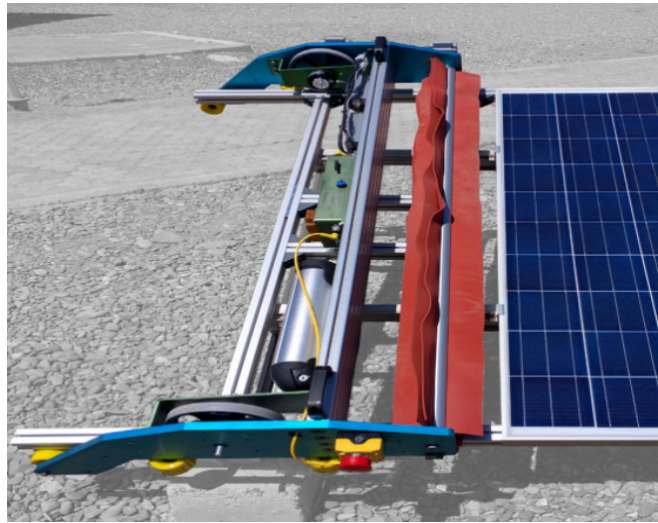
Figure 20. The robotic cleaning system was installed in the test field [47].